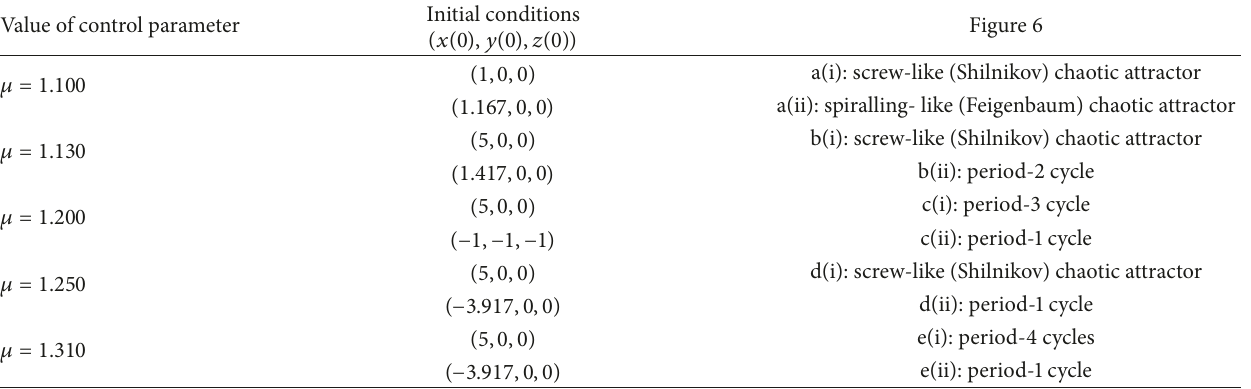
Table 1: Sample forms of coexisting attractors in terms of control parameter 𝜇